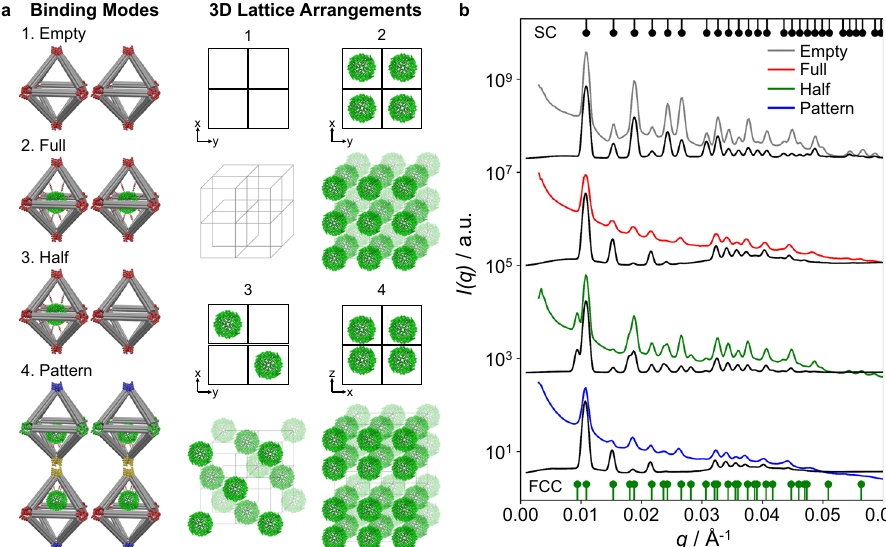
Fig. 5 Design of 3D designed ferritin arrays and their in situ SAXS analyses. a Schematic view showing the 3D protein/Octa lattices formed by encoded Octa voxel. Depending on the activated vertices and the encoding sequences which facilitated a variety of binding modes, four different types (i.e., empty, full- fi lled, half- fi lled, and pattern) of unit cells of the 3D Octa and ferritin/Octa lattices were designed, as presented by the 2D projections and 3D views. b Experimental (colored curves) and simulated (black curves) I ( q ) pro fi les (shifted vertically for clarity) of the different types of 3D ferritin/Octa lattices. Gray (empty Octa, control) and red (full- fi lled ferritin/Octa) curves correspond to a simple cubic (SC) lattice, green (half- fi lled ferritin/Octa) curve relates to an face-centered cubic (FCC) lattice, and blue (pattern ferritin/Octa) curve corresponds to a tetragonal lattice, see text and “ Methods ” section for details. The 3D indices of a SC (bottom) and an FCC lattice (top) are indicated,